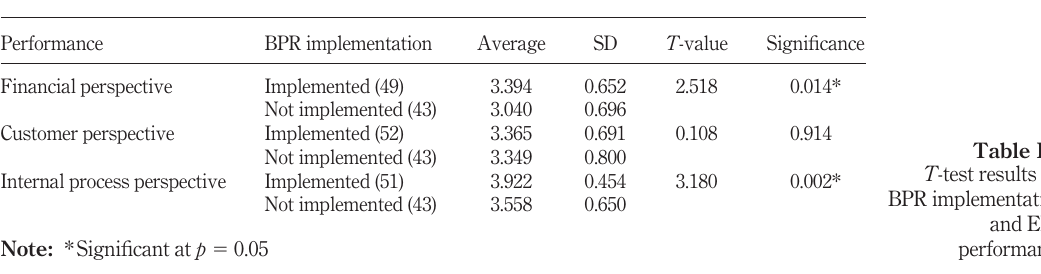
Table IV. T -test results